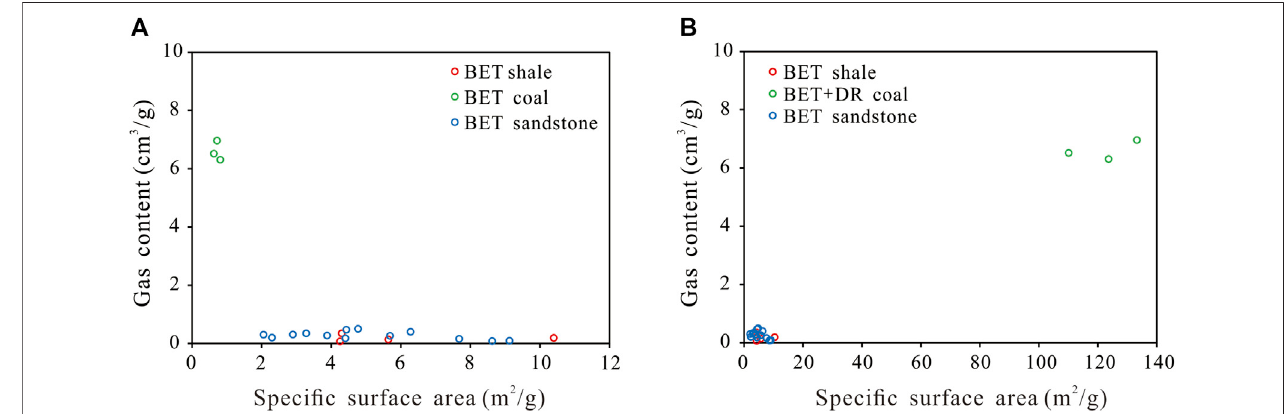
FIGURE 10 | Correlation analysis between speci fi c surface area and gas content. (A) Correlation analysis between BET speci fi c surface area and gas content. (B) On the basis of Panel A, the BET speci fi c surface area of coal is added with Dr speci fi c surface area.